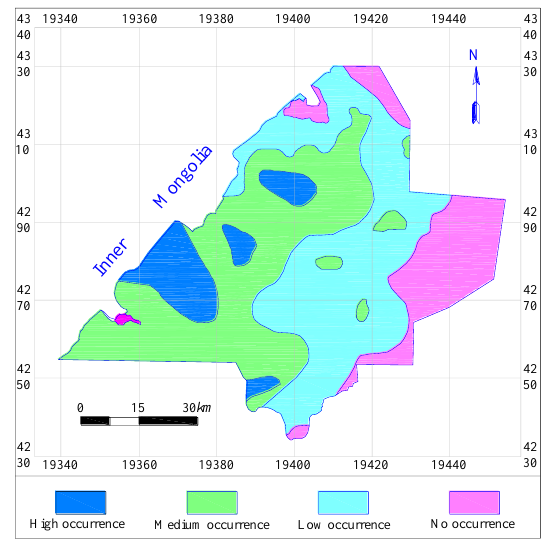
Figure 5. The major types of aquifers in the Yu-Shen mining area.